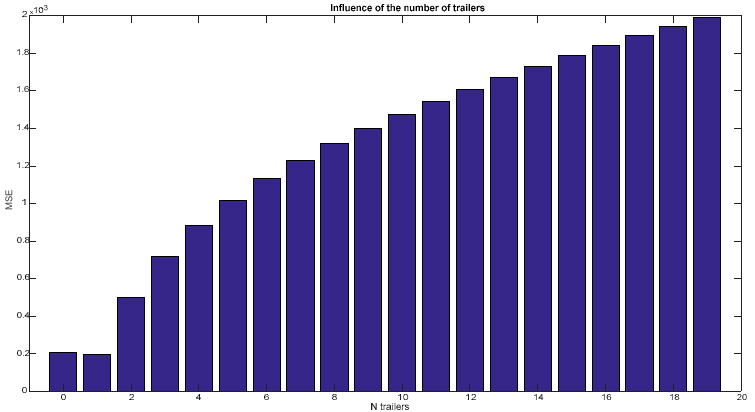
Figure 26. Influence of the number of trailers in the guiding error.